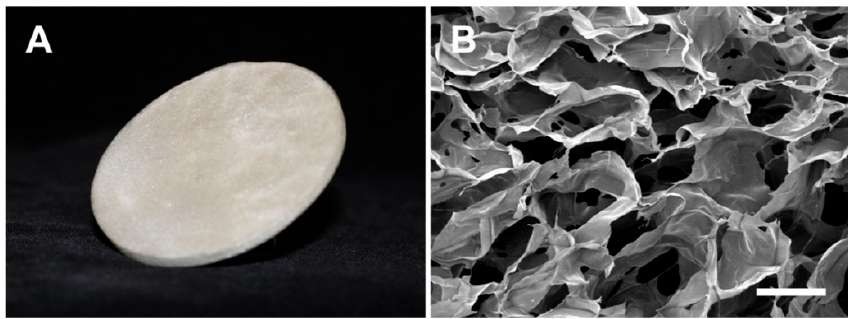
Figure 1. Salmon-gelatin biomaterial. ( A ), photographic image. ( B ), SEM image (Bar 200 µm).